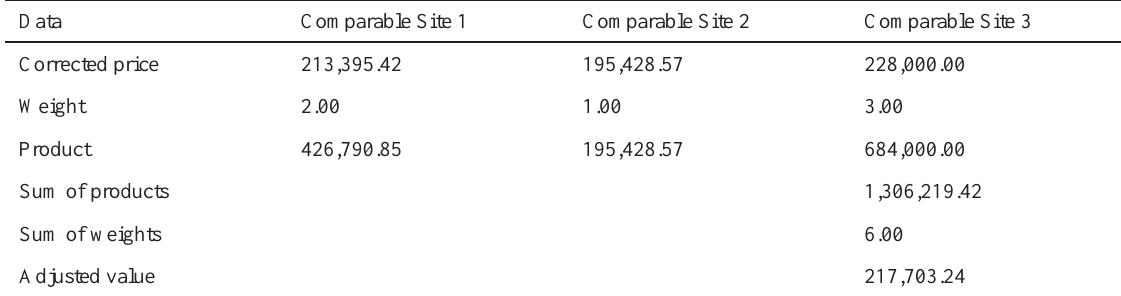
table 5. adjustment of the